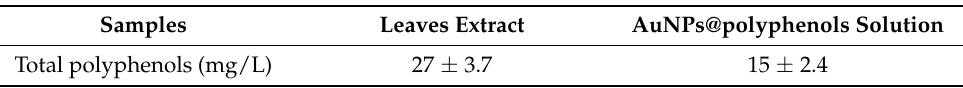
Table 1. Total polyphenol measurements in Laurus nobilis leaf extract and in Au NP@polyphenol water solution (5 µ M of Au).